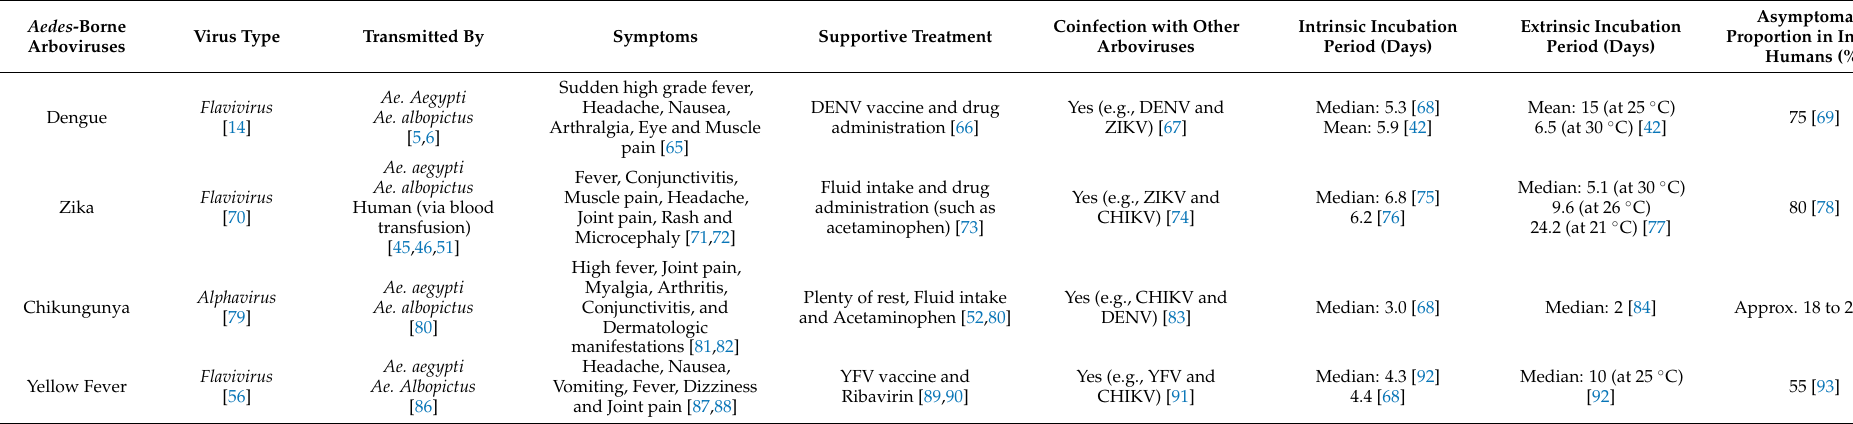
Table 1. Aedes -borne arboviral incubation periods and the asymptomatic fraction of infections Aedes -Borne